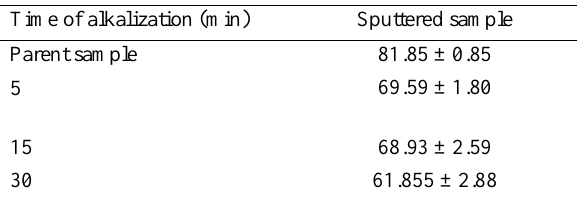
Table 1. Contact angle for various silanization methods on the treated glass slides